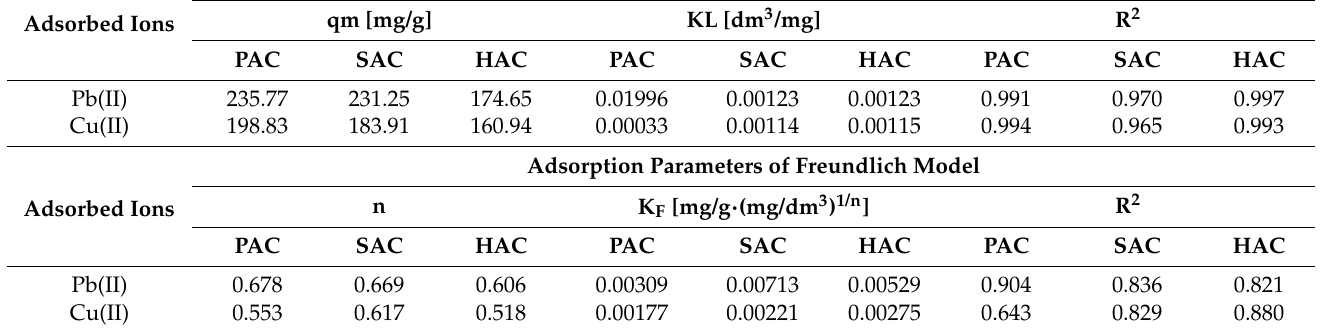
Table 8. The Pb 4f photopeaks of PAC, SAC and HAC activated biocarbons.